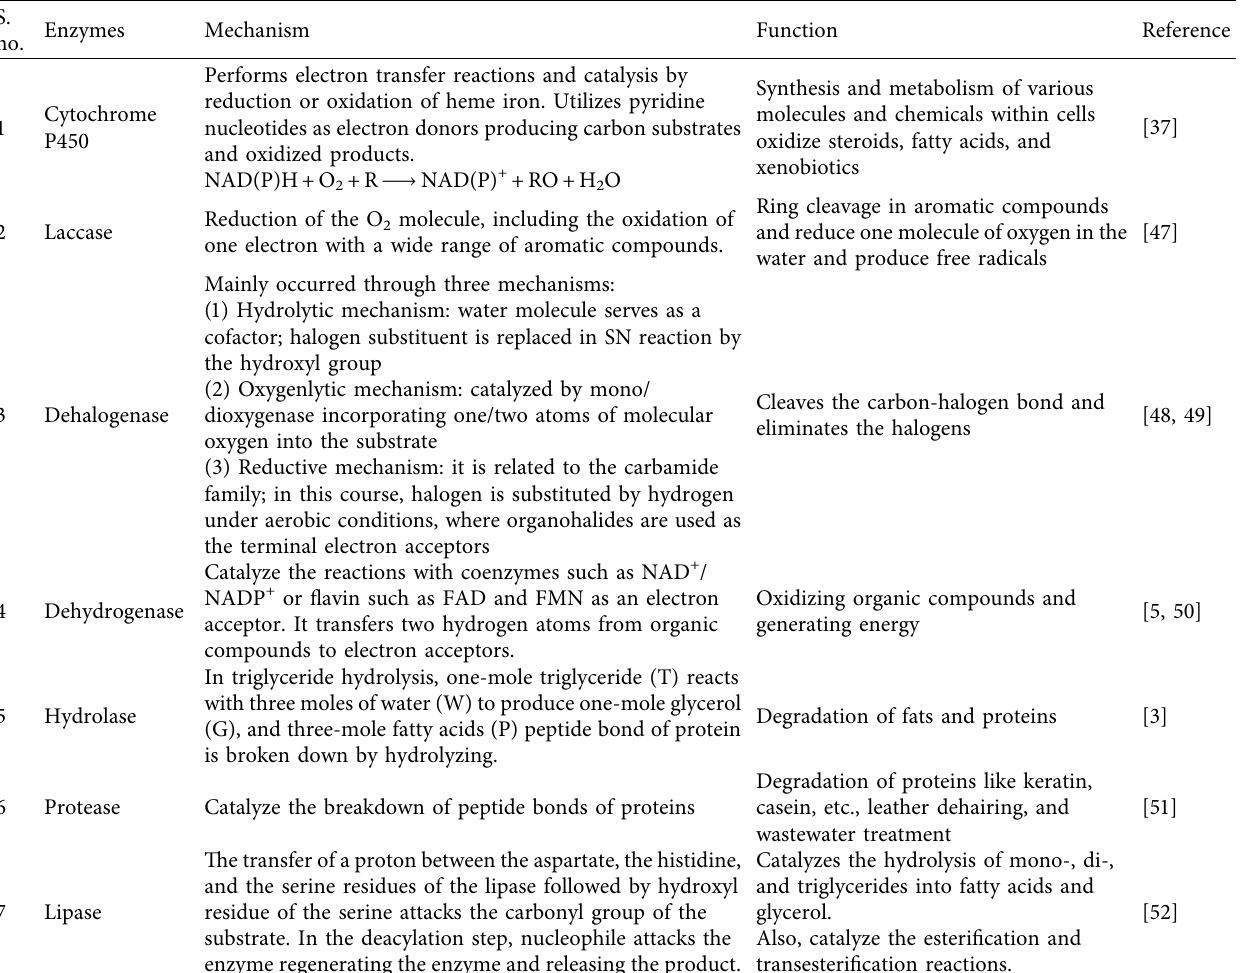
Table 2: Microbial enzymes involved in bioremediation and their